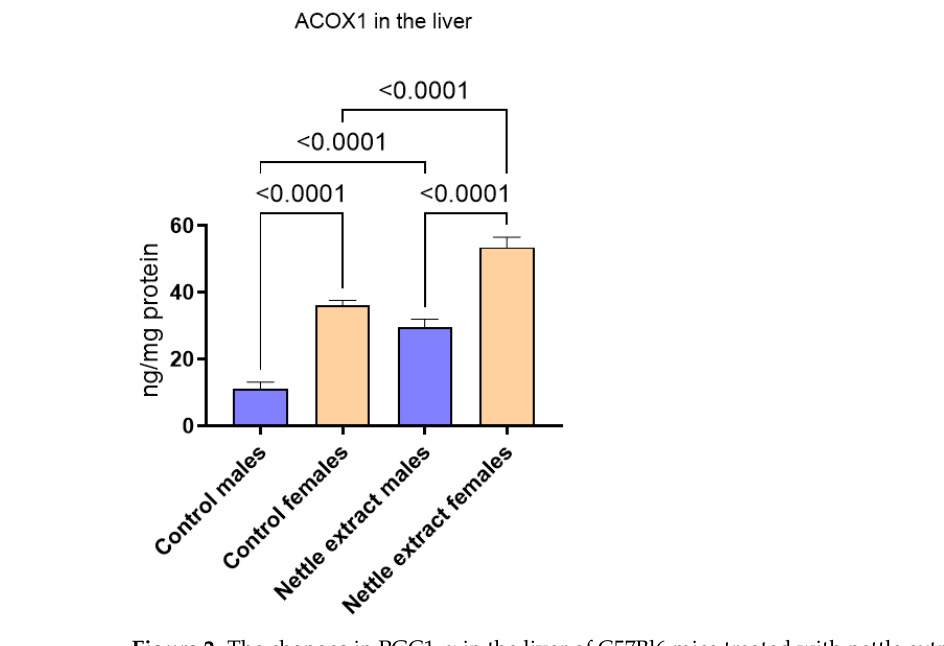
Figure 2. The changes in PGC1- α in the liver of C57Bl6 mice treated with nettle extract. The numbers above bars are p values meaning statistically significant ( p ≤ 0.05) differences between the treated groups by Kruskal–Wallis ANOVA.